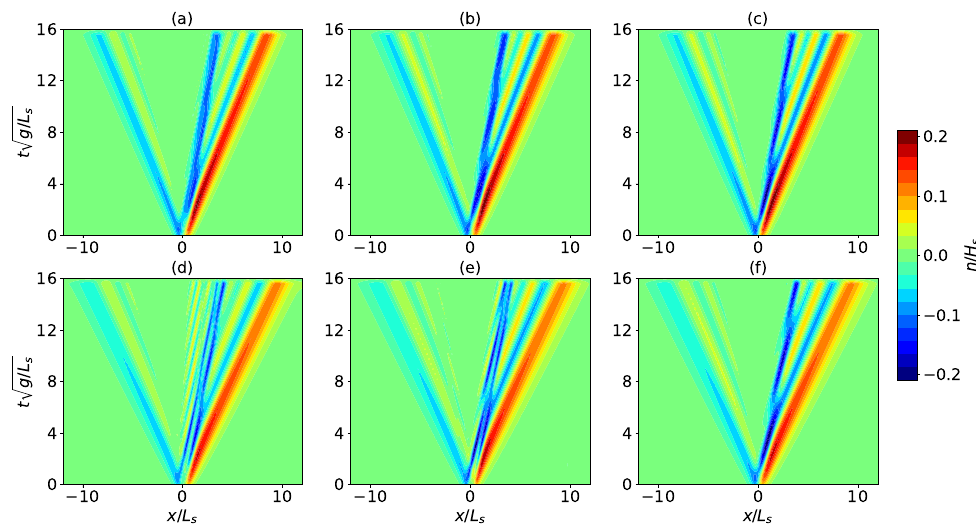
Figure 6. Comparison of wave-field contours obtained from three different wave models: ( a , d ) NH-1L model. ( b , e ) LWD model. ( c , f ) LFD model. ( a – c ) µ = 0.3. ( d – f ) µ = 0.4. The dashed lines represent (cid:112) gd 0 . the characteristic curves with wave celerity ±